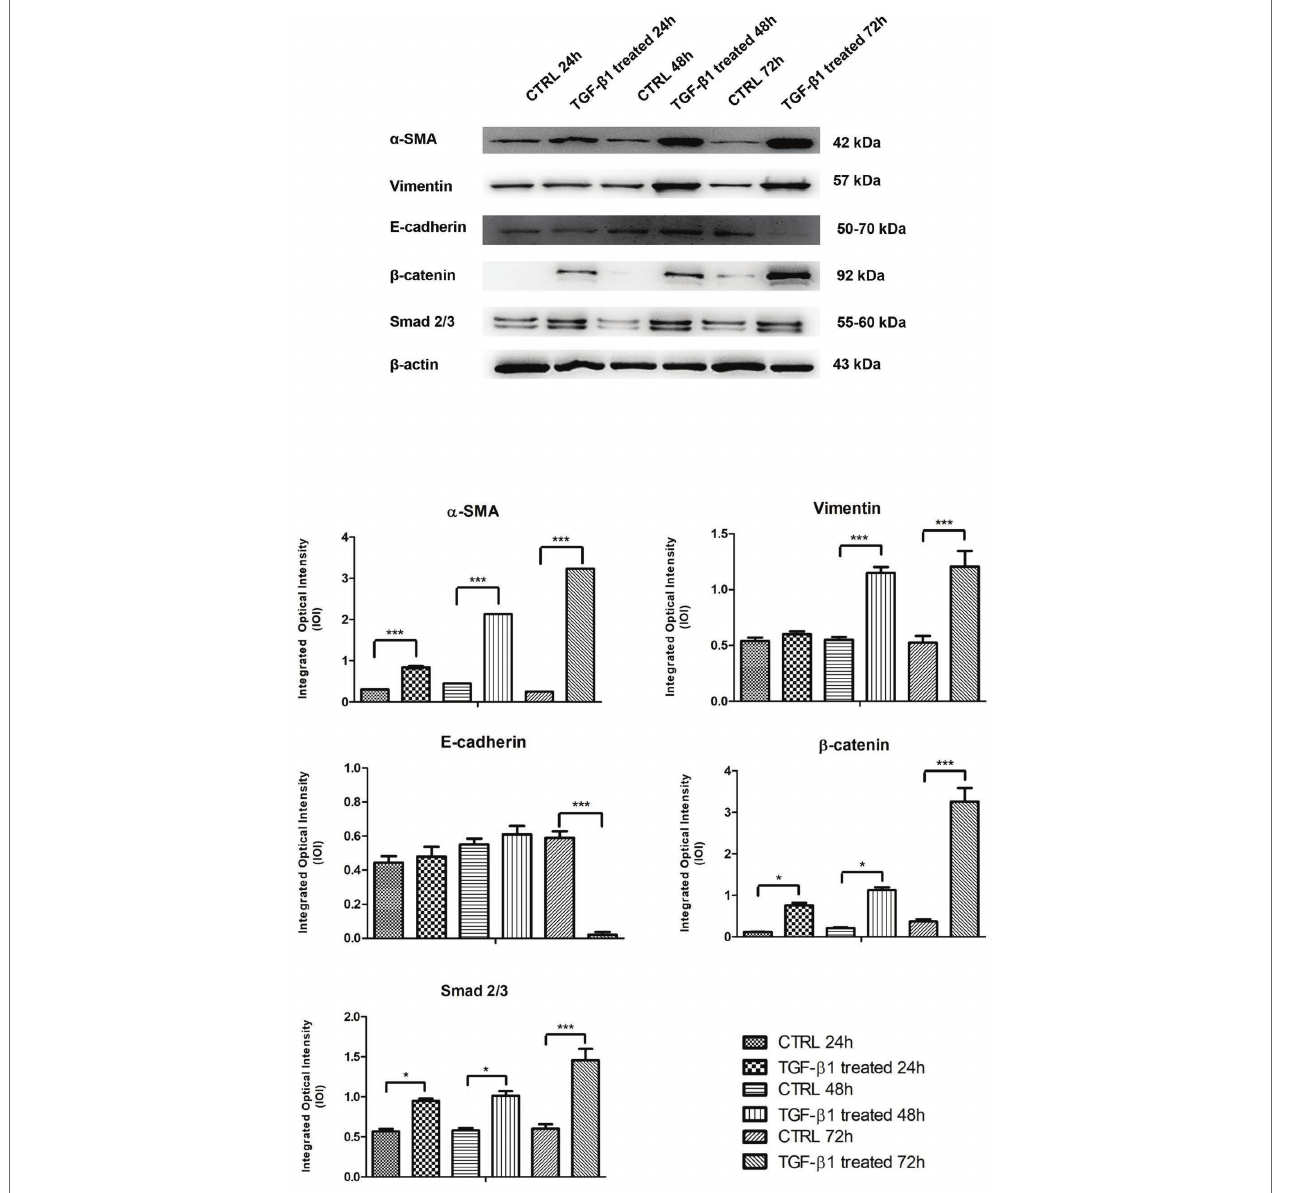
FIGURE 7 | Western blotting analysis of α -SMA, Vimentin, E-cadherin, β -catenin, and Smad 2/3 expression in primary hGFs treated with TGF- β 1 (10 ng/ml) after 24, 48, and 72 h. Each membrane was probed with β -actin antibody to verify protein loading consistency. The given Western blot is the representative image of three different experiments. Histograms represent densitometric measurements of proteins bands expressed as Integrated Optical Intensity (IOI) mean of three separate experiments. The error bars on the graphs show standard error of the mean (±SEM). * p < 0.01; *** p <